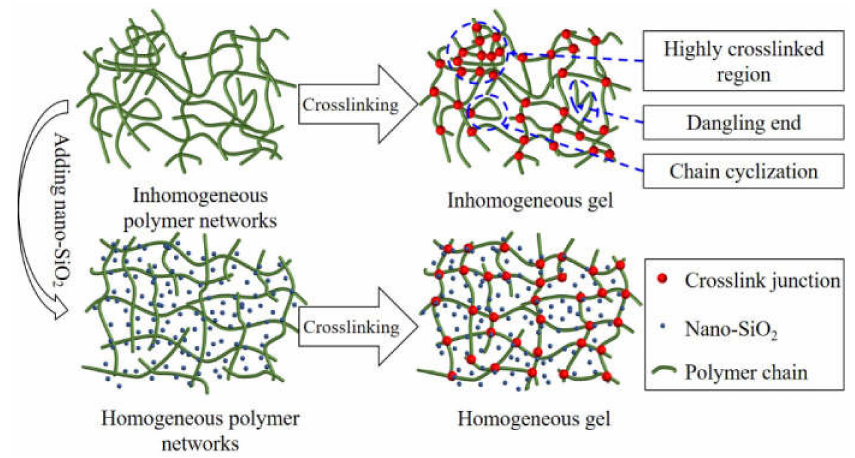
Figure 9. Mechanism of gel strengthening by nano-SiO 2 .